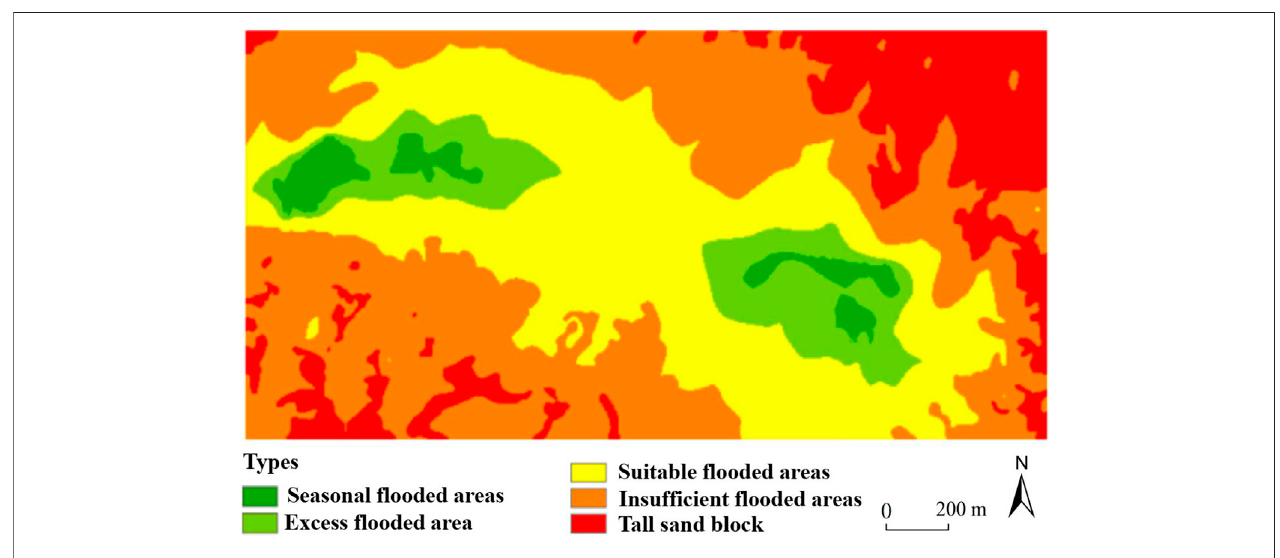
FIGURE 3 | Water condition division of the test